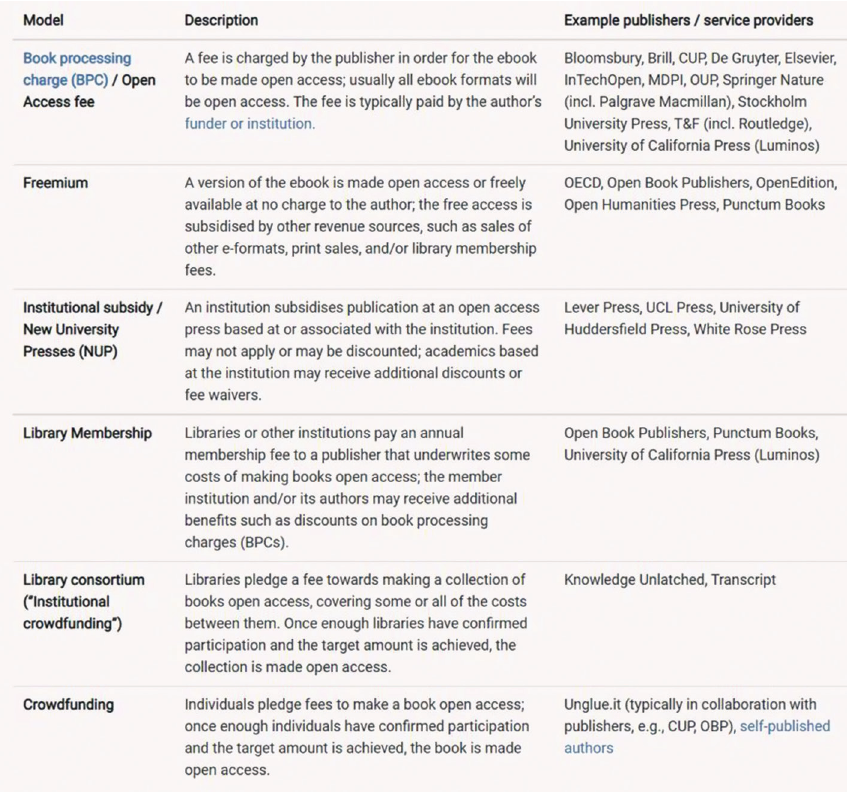
Fig. 1: Open Access Book Models by OAPEN